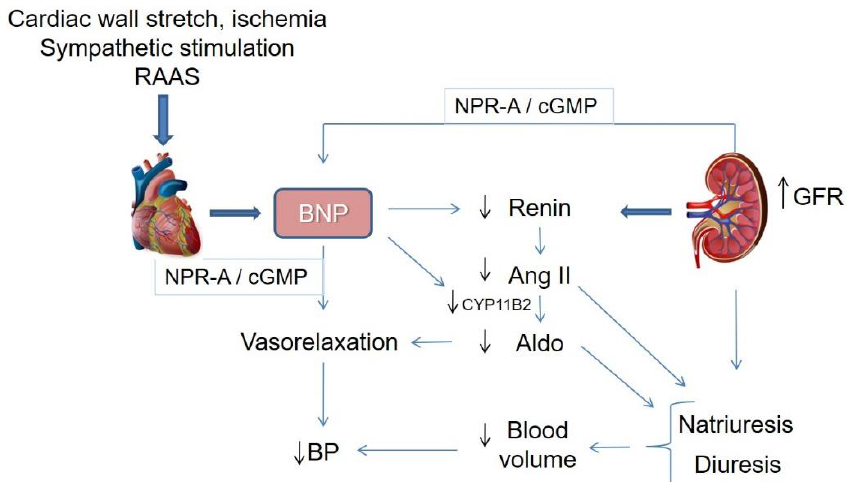
Figure 2. BNP as a counterregulatory system of the renin angiotensin II aldosterone system (RAAS). Aldo, aldosterone; Ang II, angiotensin II; BP, blood pressure; BNP, brain natriuretic peptide; CYP11B2, cytochrome P450 family 11 subfamily B member 2 (aldosterone synthase); cGMP, cyclic guanosine monophosphate; GFR, glomerular filtration rate; NPR-A, natriuretic peptide receptor A.